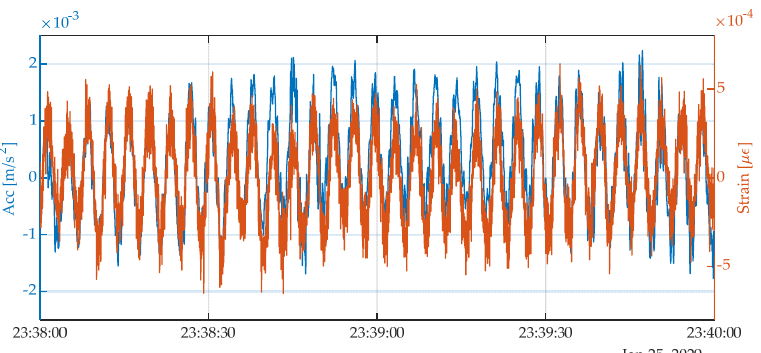
Figure 5. Synchronization of the KMI system (force-balance S3) and cRIO system (strain gauge B). The synchronization of SCADA data was performed by comparing the evolution of the yaw angle (SCADA high-resolution) with the time series of strains over a full rotation of the nacelle. The eccentricity of the nacelle and rotor mass generates a sinusoidal signal in the strain gauges, as shown in Figure 6. A constant delay of approximately 50 s was observed between the two systems.